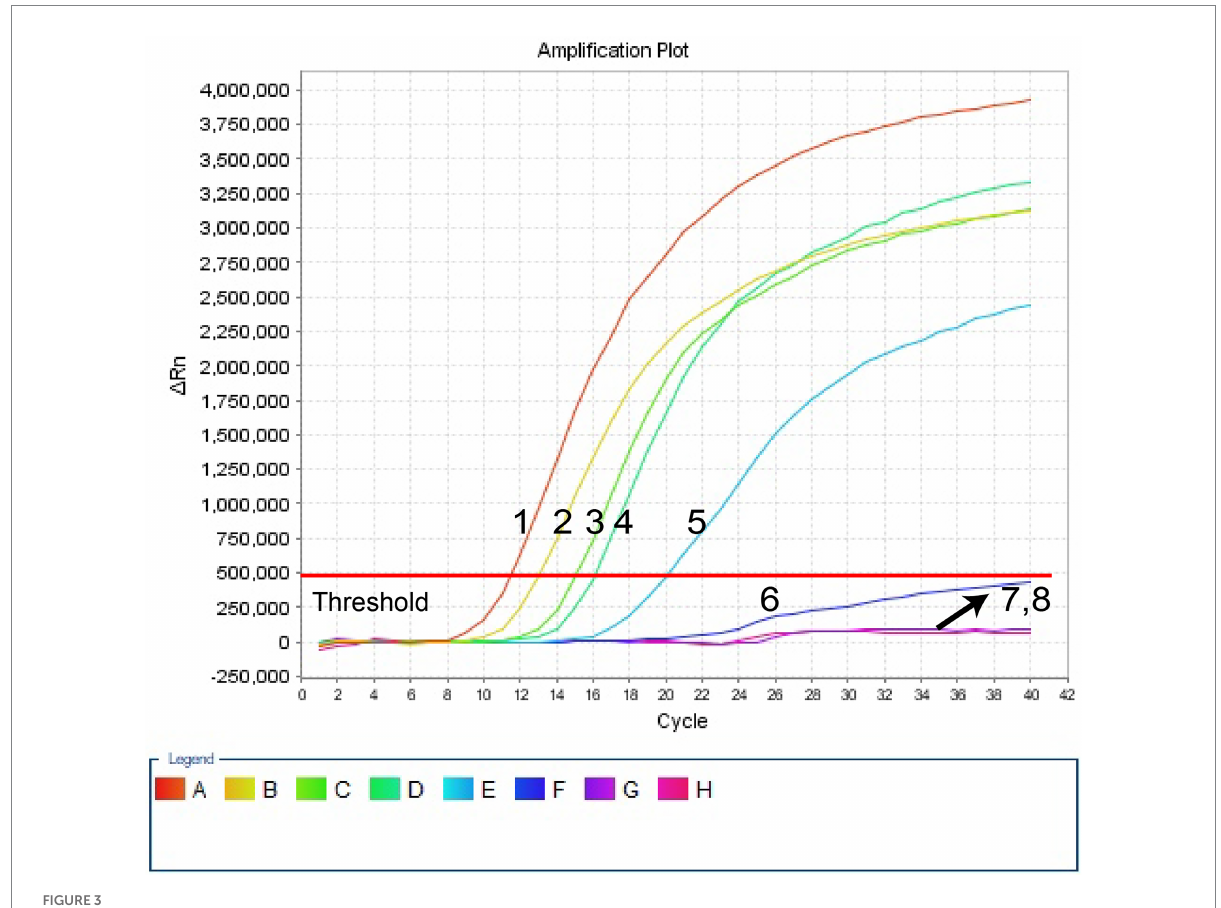
FIGURE 3 Sensitivity of H. influenzae- ERT-LAMP assay. Signals 1–7 indicate a series of dilutions (400 pg, 40 pg, 4 pg, 400 fg, 40 fg, 4 fg, 400 ag) of pUC57-Hi-OMP P6 DNA and a blank control (DW) were operated according to standard H. influenzae- ERT-LAMP